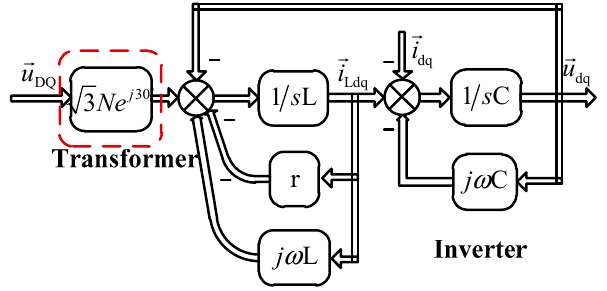
Figure 3. Complex state variable structure.